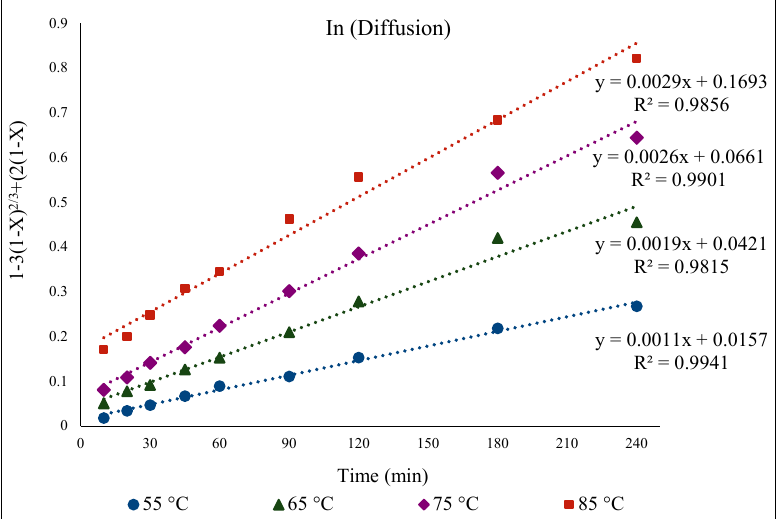
Figure 13. [1 − 3(1 − X) 2/3 + 2(1 − X) = k.t] over time (min) for temperatures from 55 to 85 °C for In extraction in 30% v/v [Bmim + HSO 4 − ] solution with 1 g of oxidant Fe 2 (SO 4 ) 3 . There was a low extraction yield of Ga throughout this work, most likely due to Ga being inherently less active or soluble in the ionic liquid medium. Nevertheless, the kinetics of Ga dissolution in the 30% v / v [Bmim + HSO 4 − ] solution (Figure 15) correlated well with the diffusion-controlled model, again showing two distinct kinetic regions. The activation energy for Ga in the first part of the extraction (10–45 min) was 12.2 kJ/mol, and it was 30.3 kJ/mol in the second part, correlating with the slower Ga extraction depicted in Figure